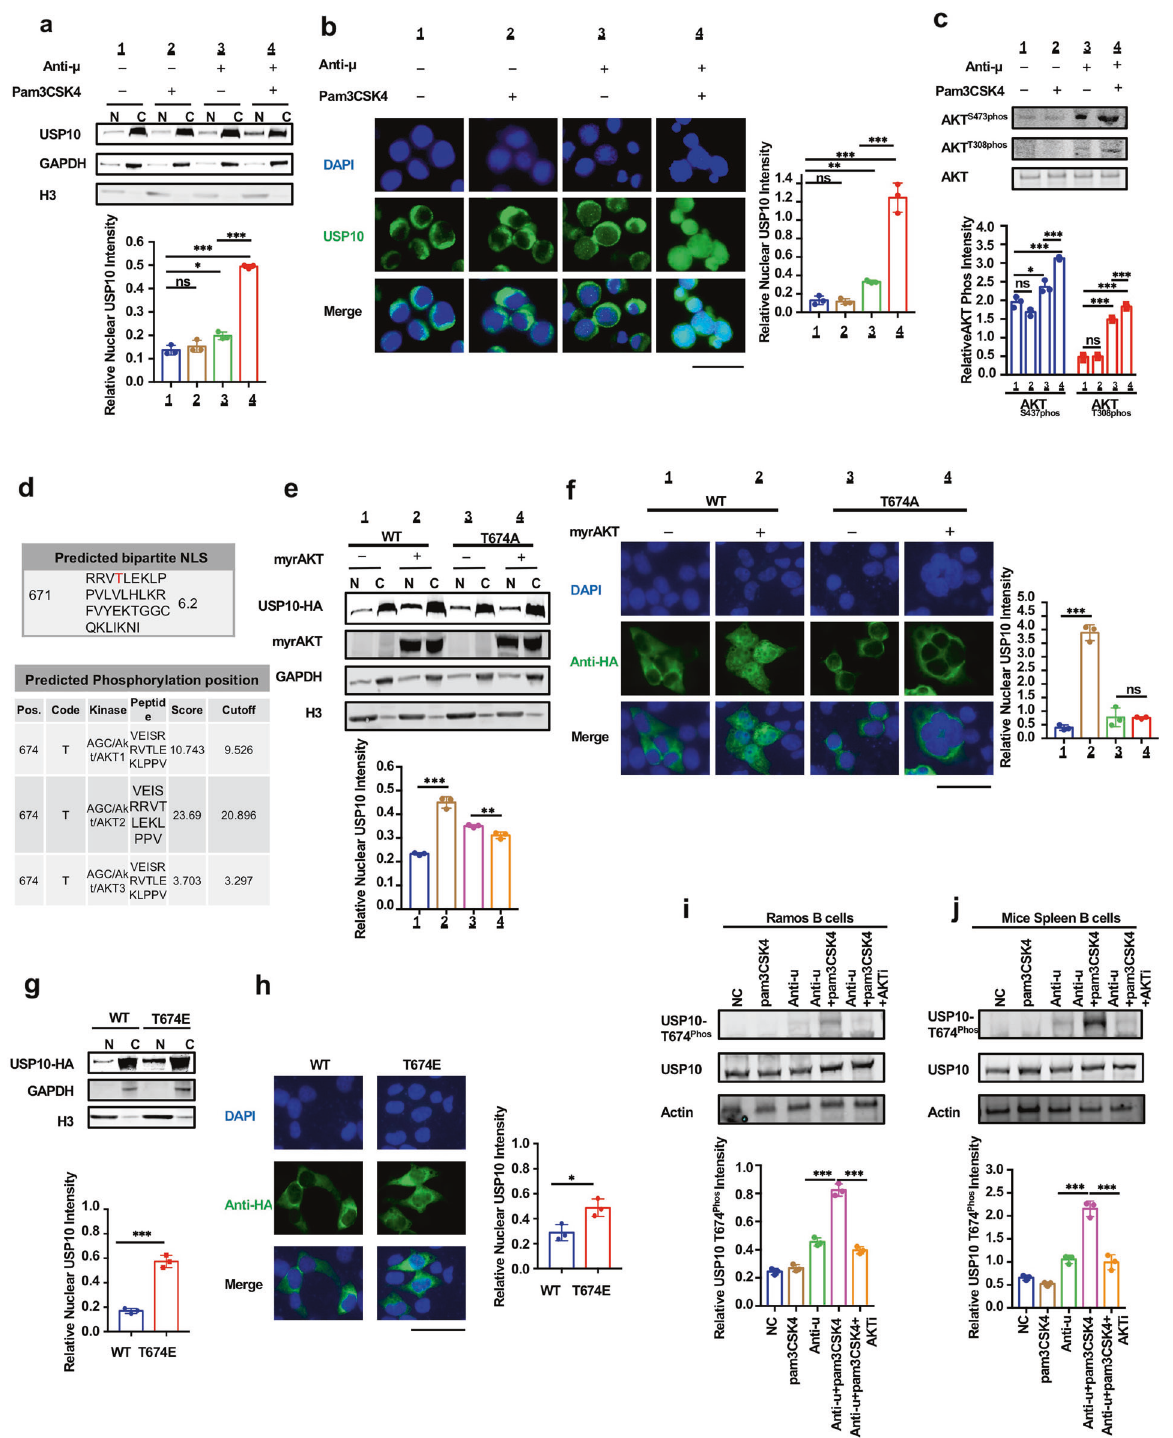
Fig. 6 BCR and TLR2 activation synergistically inhibited AID degradation in the nucleus through Akt-mediated USP10 T674 phosphorylation and nuclear translocation. a , b TLR1/2 and BCR co-stimulation promoted USP10 nuclear translocation. a Nucleus – cytoplasm separation experiment. b The immuno fl uorescence assay. c Western blot showed that TLR1/2 and BCR co-stimulation enhanced AKT S437 phosphorylation and T308 phosphorylation compared to anti- μ stimulation alone in Ramos B cells. d The 671-705 severed as a nuclear localization signal (NLS) of USP10. The T674 in USP10 NLS may be an AKT phosphorylation site. e , f The myrAKT increased USP10 nuclear translocation but not T674A USP10. e Nucleus – cytoplasm separation experiment, H3 as was used as a nuclear loading control. f Immuno fl uorescence assay. g , h T674E USP10 performed more nuclear distribution compared with wild-type USP10. g Nucleus – cytoplasm separation experiment, H3 as was used as a nuclear loading control. h Immuno fl uorescence assay. I , j Western blot indicated TLR1/2 and BCR co-stimulation promoted USP10 T674 phosphorylation, but not when AKT inhibitor treatment. i in Ramos B cells, j in Mice spleen B cells. Data were representative of multiple experiments. * P < 0.05, ** P < 0.01, *** P < 0.001. The scale bar in image data is 50 μ m